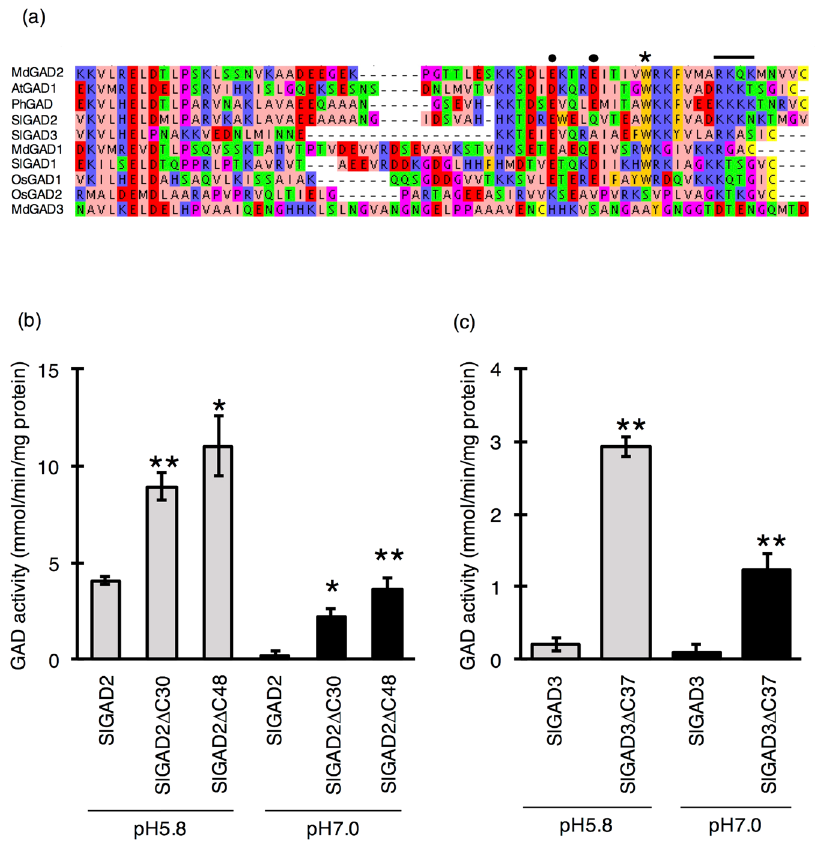
Figure 1. Determination of the target sites within SlGADs’ C-terminal regions. ( a ) Multiple sequence alignment of the C-terminal region of 10 plant GADs. The C-terminal of MdGAD1-3, AtGAD1, PhGAD, OsGAD1-2, SlGAD1-3 from Malus domestica (apple), Arabidopsis thaliana , Oryza sativa (rice), and Solanum lycopersicum (tomato), respectively, which were obtained in a previous study, were compared. The conserved tryptophan (W) residue and lysine (K) clusters involved in CaM-binding 19, 48 are indicated by an asterisk and a black line, respectively. The two glutamate (E) residues functioned as pseudo-substrates and are likely involved in autoinhibition in PhGAD 43 are indicated as black circle. Accession Numbers: MdGAD1, KC812242; MdGAD2, KC812243; MdGAD3, KC812244; AtGAD1, AY094464.1; AtGAD2, U49937.1; PhGAD, L16977; SlGAD1, AB359913; SlGAD2, AV359914.1; SlGAD3, AB359915.1; OsGAD1, AB056060; OsGAD2; AB056061. ( b and c ) GAD activity of SlGAD2 Δ C30 and SlGAD2 Δ C48, and SlGAD3 Δ 37, respectively, in in vitro assays. Crude extracts from Escherichia coli were used in GAD enzymatic assays and Ca 2 + was not included in reaction buffers. SlGAD2 and SlGAD3 are full-length GADs, whereas SlGAD2 Δ C30, SlGAD2 Δ C48, and SlGAD3 Δ C37 are truncated GADs at C-terminal positions 30, 48, and 37, respectively. Bars represent the standard deviation (n = 3) and asterisks indicate statistical differences in according to the Tukey-Kramer’s test between full-length GADs ( * P < 0.05 and ** P <